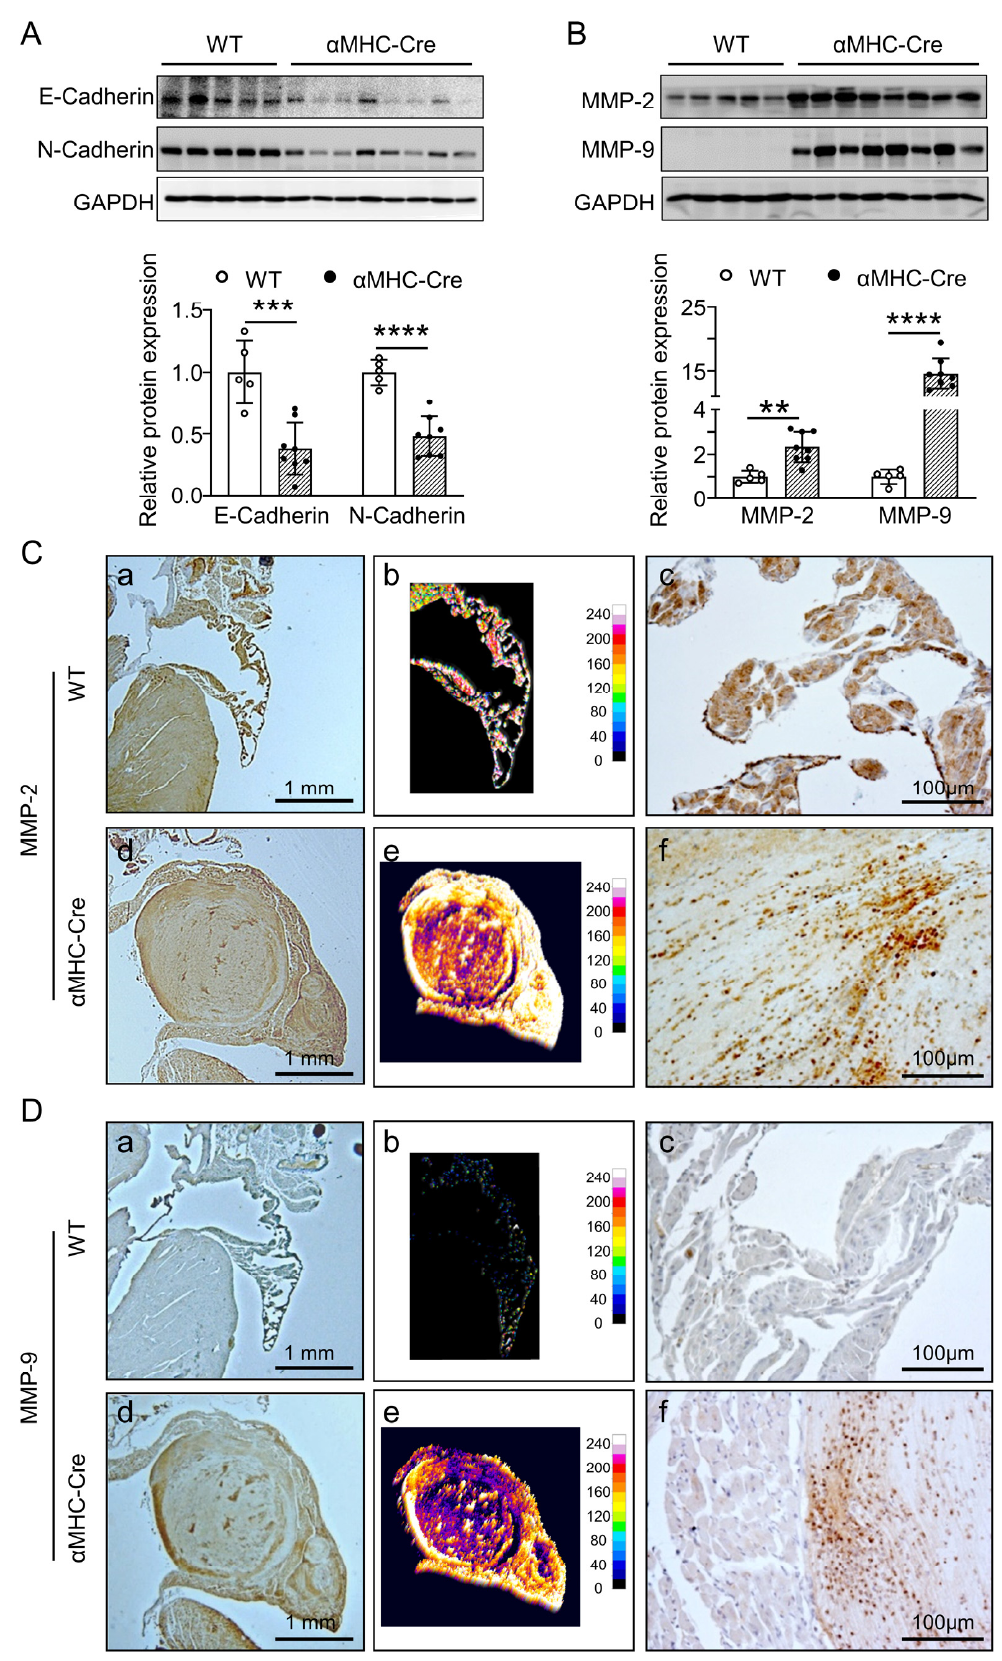
Figure 3. Abnormal expression of tumor-associated proteins in left atrium of α MHC-Cre mice at six months of age. ( A ) Western blots and quantification of E-Cadherin and N-Cadherin levels in left atrium (normalized to GAPDH) from six-months-old WT and α MHC-Cre mice. ( B ) Western blots and quantification of MMP-2 and MMP-9 levels in left atrium (normalized to GAPDH) from six-